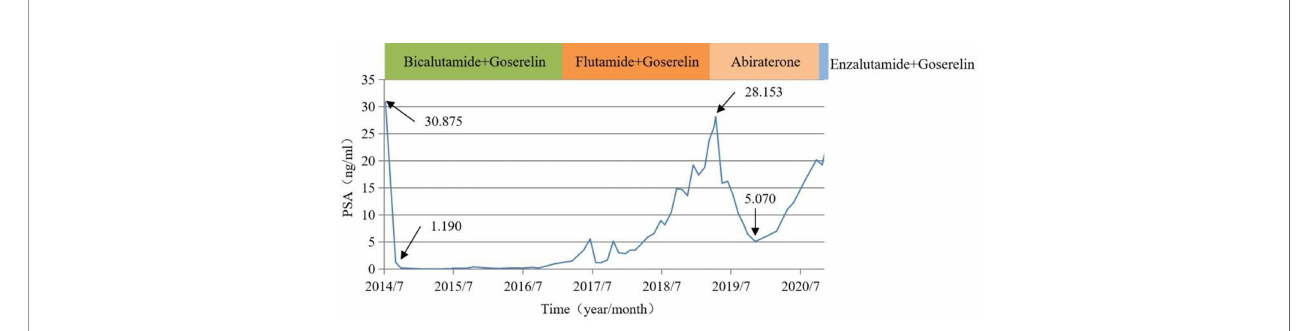
FIGURE 1 | Changes in PSA levels and medications after